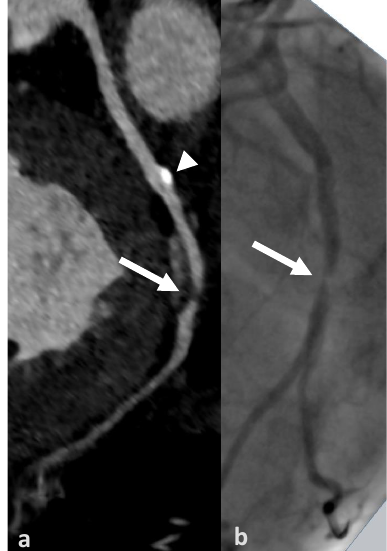
Figure 4. True positive cCTA example (CAC = 1235): Curved multiplanar reconstruction of the left circumflex artery (LCX) with non-calcified plaque and stenosis of 70% (arrow) in the distal LCX (segment 13) and a calcified plaque (arrowhead) in the proximal LCX (segment 11) ( a ). Corresponding projection of the invasive coronary angiography well depicting the stenosis (arrow); note the calcified non-stenotic plaque is not visible ( b ). CAC = coronary artery calcium